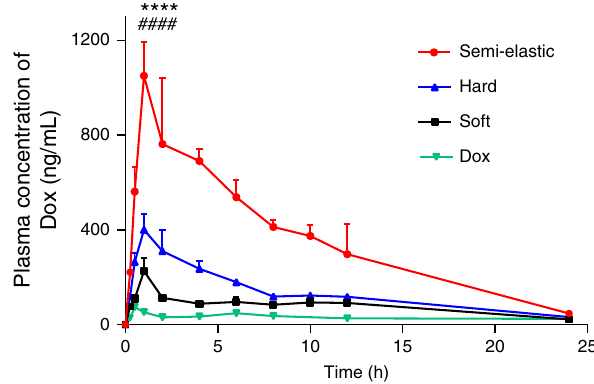
Fig. 5 Plasma concentration vs. time pro fi le of different Dox formulations after oral administration in a dose equivalent to 10 mg/kg of free Dox. Data are shown as the means ± standard deviations (SDs). ( n = 3) **** P < 0.0001, PLGA 70 -Lip-F127 5% compared to Lip-F127 5% , and #### P <